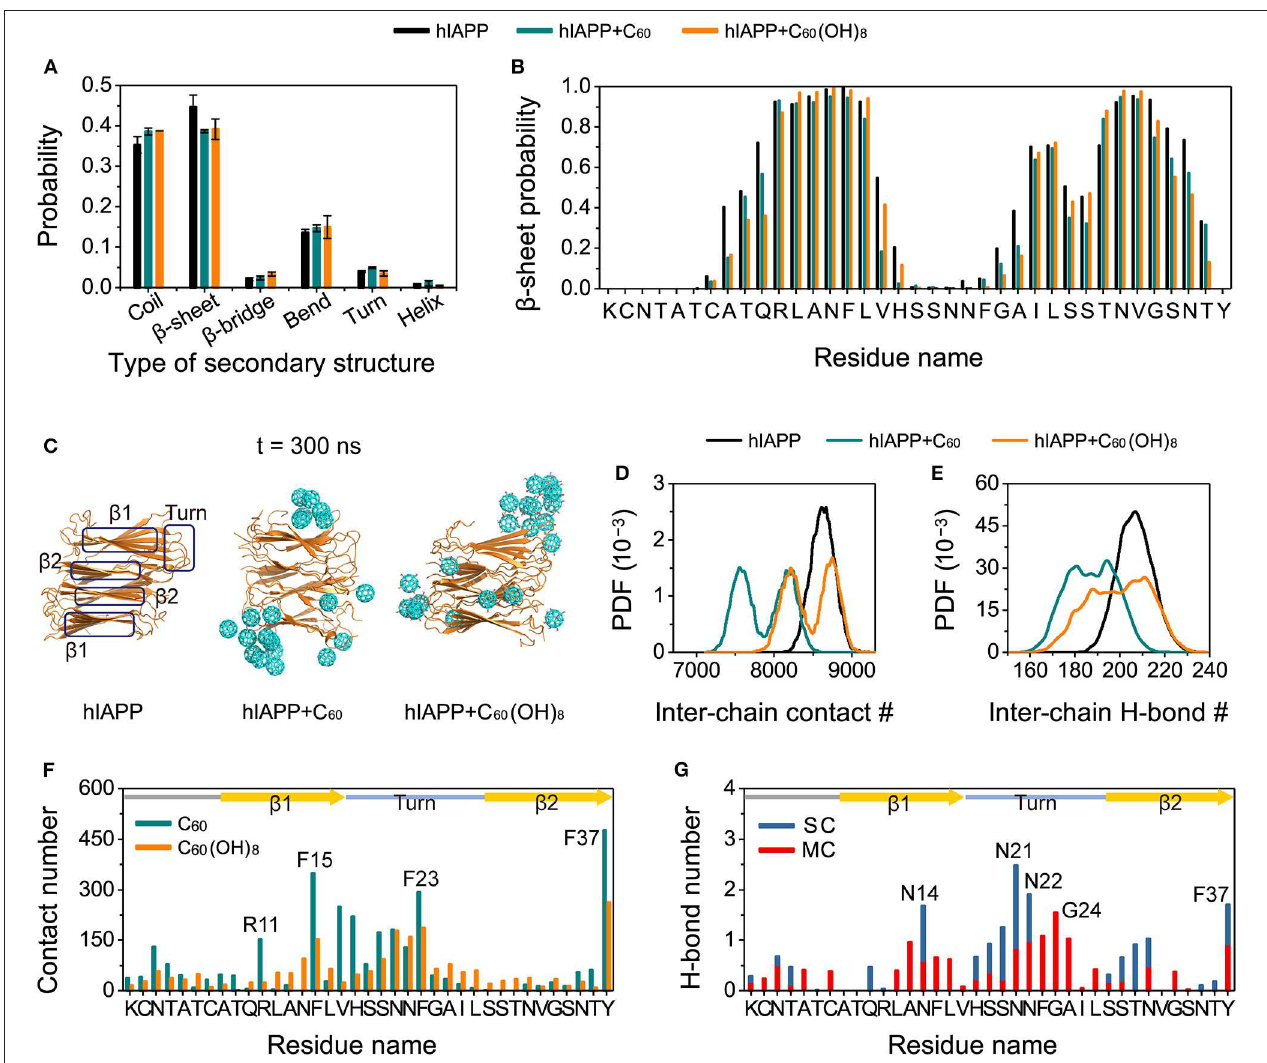
FIGURE 6 | Influences of C 60 and C 60 (OH) 8 on the hIAPP protofibril. The average probability of each type of secondary structure (A) , the β -sheet probability of each amino acid of hIAPP (B) , the snapshots of hIAPP protofibril at t = 300 ns (C) , the PDF of the inter-chain contact number (abbreviated as # ) (D) and the inter-chain H-bond number (E) for hIAPP-fibril, hIAPP-fibril + C 60 , and hIAPP-fibril + C 60 (OH) 8 systems, contact number between C 60 /C 60 (OH) 8 and each amino acid of hIAPP (F) , the number of H-bond formed between C 60 (OH) 8 and the main-chain (MC) and side-chain (SC) atoms of each amino acid (G) . The β 1, β 2, and turn regions are highlighted by rectangles in (C) and by yellow arrows and light blue line in (F,G)